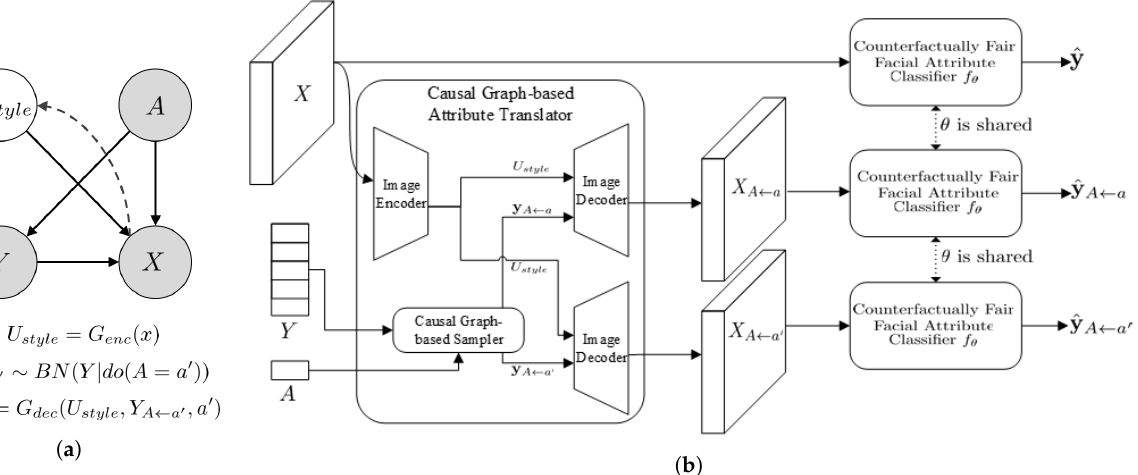
Figure 1. Illustration of the proposed framework. ( a ) The generation and inference process of the causal graph-based counterfactual attribute translator. Solid and dashed lines indicate the generation and inference process, respectively. The relationships between the sensitive attribute A and facial attributes Y are modeled in Bayesian Network ( BN ). The encoder G enc and G dec are modeled in autoencoder with adversarial loss. ( b ) The proposed learning framework. From the observed image X , two different types of counterfactual images are generated using the Causal Graph-based Counterfactual Attribute Translator. The total loss function consists of cross-entropy loss between ˆ y and y and the counterfactual regularization that absolute difference between predictions of the generated facial images ˆ y A ← a , and ˆ y A ← a (cid:48) . where Y (cid:48) is generated on the intervention of A = a (cid:48)